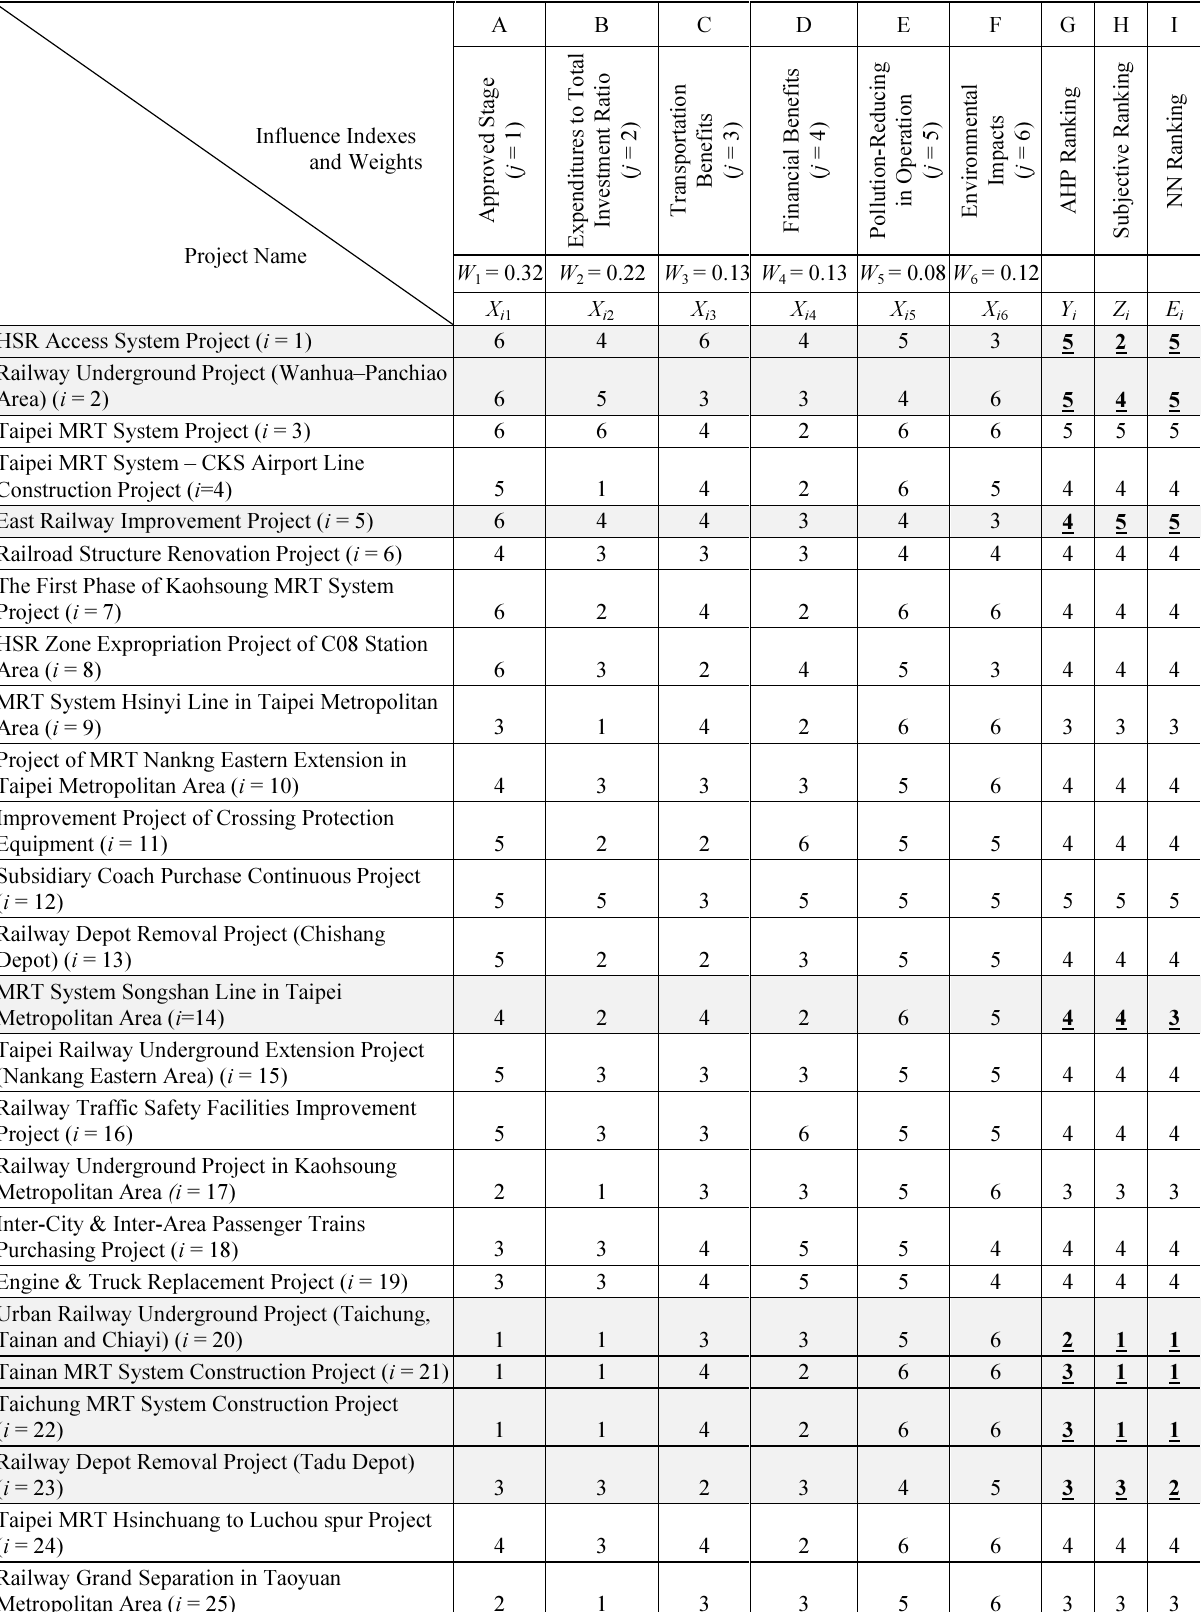
A B C D E F G H g a S t d ov e pp r A